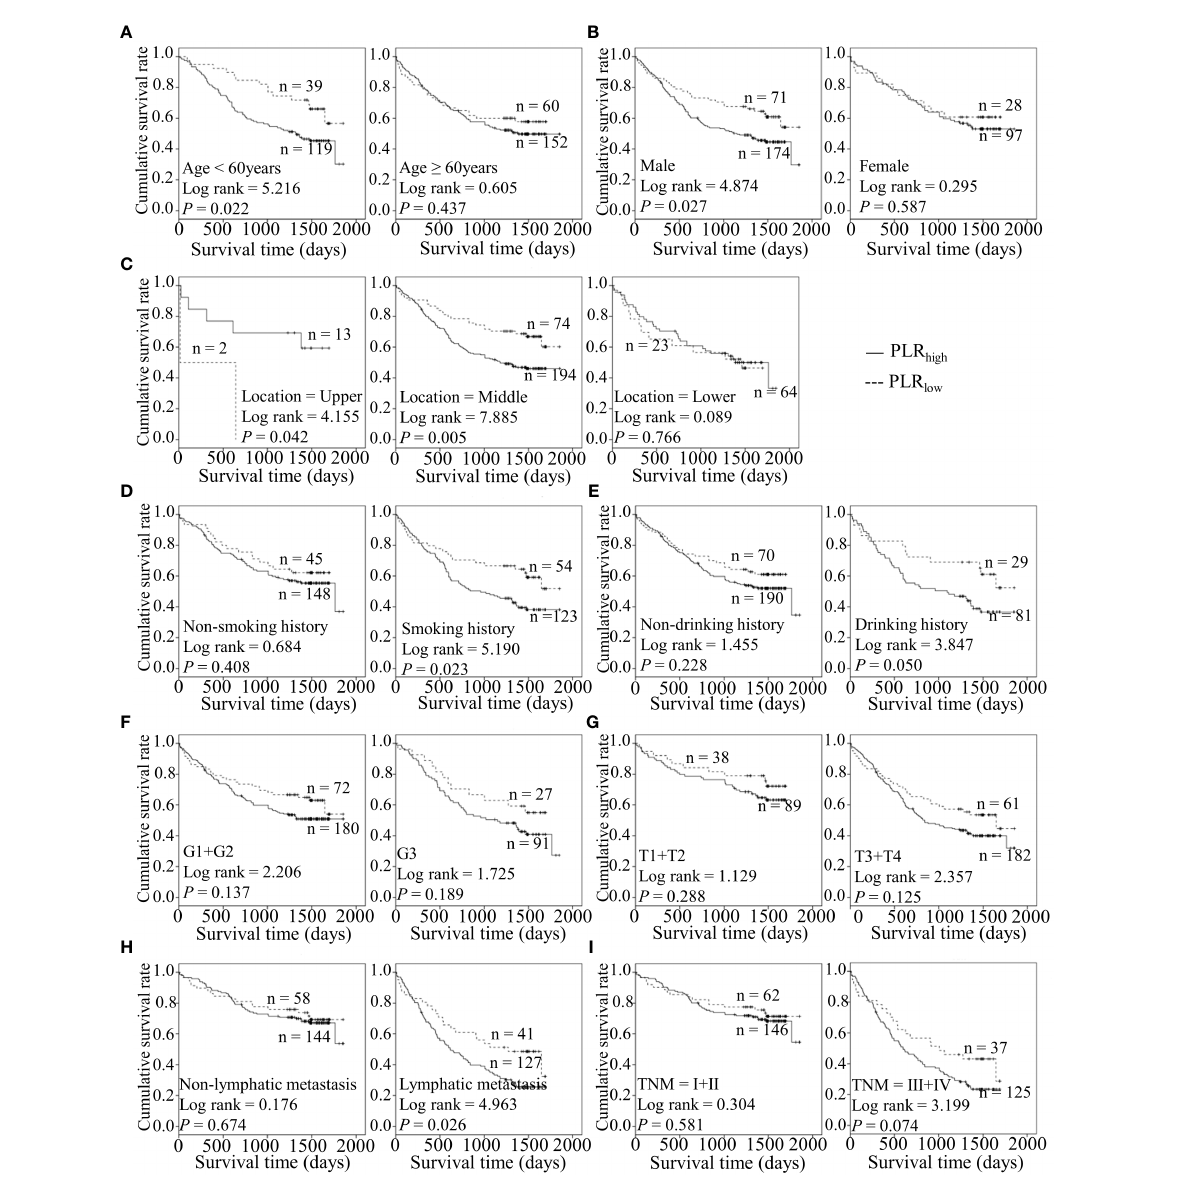
FIGURE 5 Predicating role of preoperative PLR level for the OS of ESCC patients. (A – I) Kaplan-Meier survival curves of ESCC patients with different PLR levels combined with diverse features like age (A) , gender (B) , tumor location (C) , smoking history (D) , drinking history (E) , tumor grade (F) , T stage (G) , lymph node metastasis (H) and TNM staging (I)